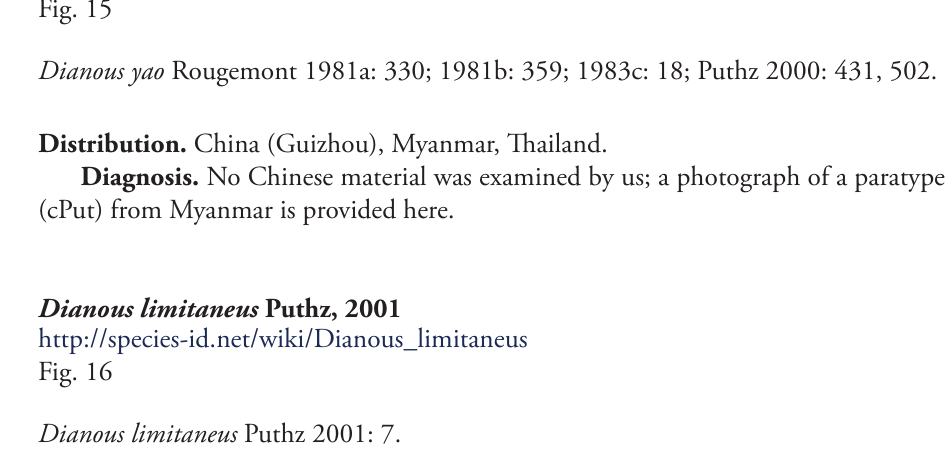
Material examined. Holotype: CHINA: Yunnan: female, Baoshan Xian, Gongshan Mts., Lujiaba, 2400m, 10.X.1996, K. Ishii et al. leg. Distribution. China